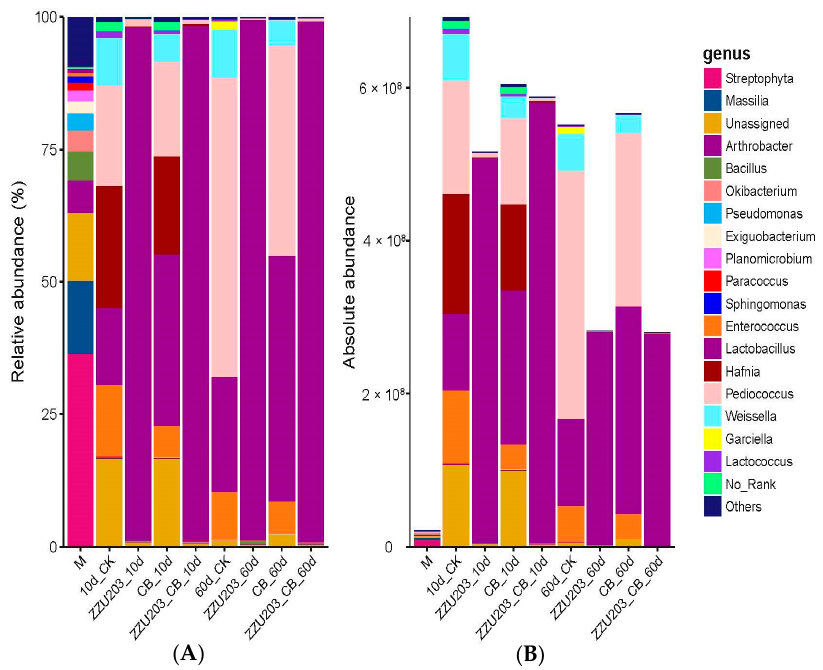
Figure 6. Bar plots of bacterial communities in alfalfa silage illustrated using RQS ( A ) and AQS ( B ). Table 2. Bacterial communities in alfalfa silage illustrated using RQS and AQS of genera at 10 and 60 days. RQS (%) AQS (Copies/ng DNA) Ensiling Days Genus Treatments